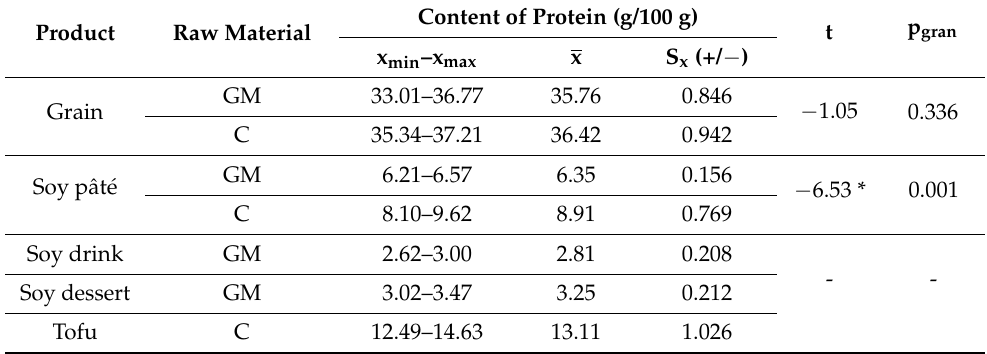
Table 1. Protein content in soybean grain and soy